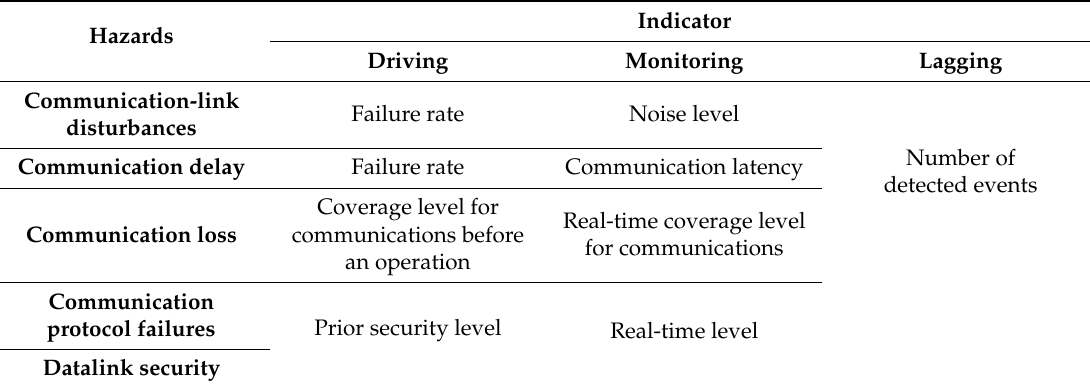
Table 4. Safety indicators regarding communication protocols and